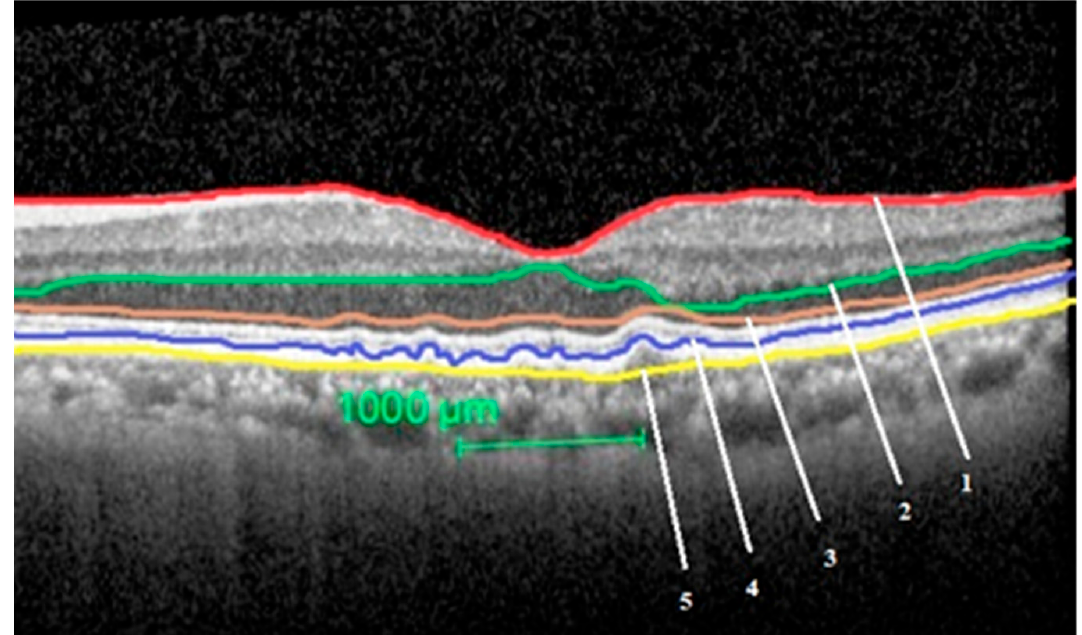
Figure 1. Segmentation of the study layers in an eye with intermediate age related macular degeneration (ARMD). Total retinal thickness = between layer 1 and 5, outer nuclear layer thickness = between layer 2 and 3, outer retinal layer thickness = between layer 3 and 5, retinal pigment epithelium-Bruch’s membrane (BM) complex thickness = between layer 4 and 5.